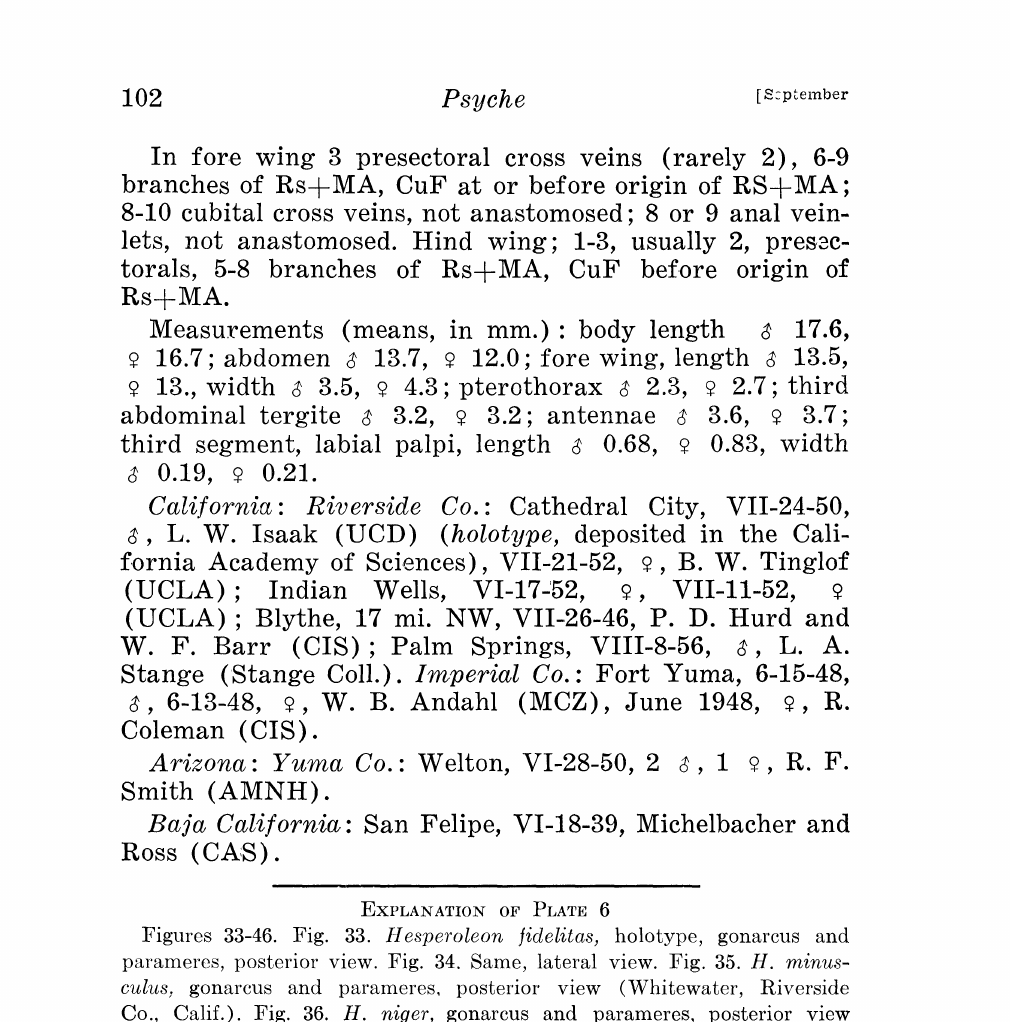
parameres, posterior view. Fig. 34. Same, lateral view. Fig. 35. H. minus-